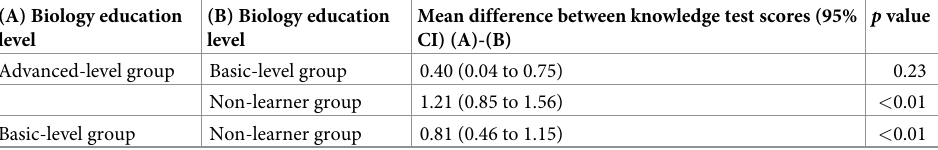
Table 4. Tukey’s test results for level of high school biology education and knowledge test